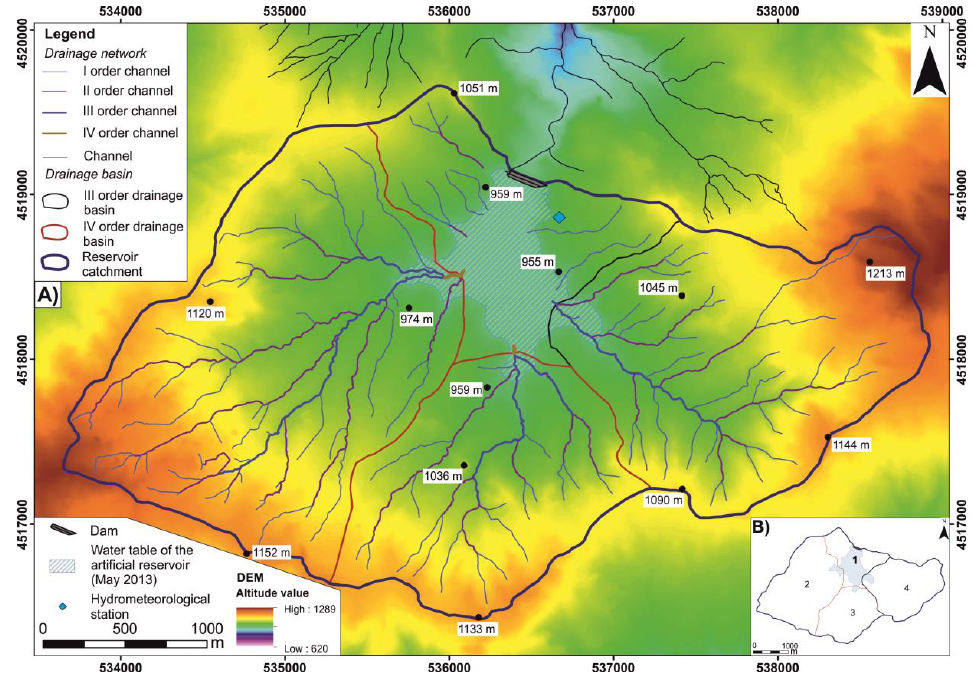
Figure 3. ( A ) Drainage network of the study area and relative hierarchization according to the Strahler’s orders. Hydro-meterological station (coordinates: 40.8207 ◦ N; 15.4338 ◦ E) is also shown. ( B ) Numbering of the drainage